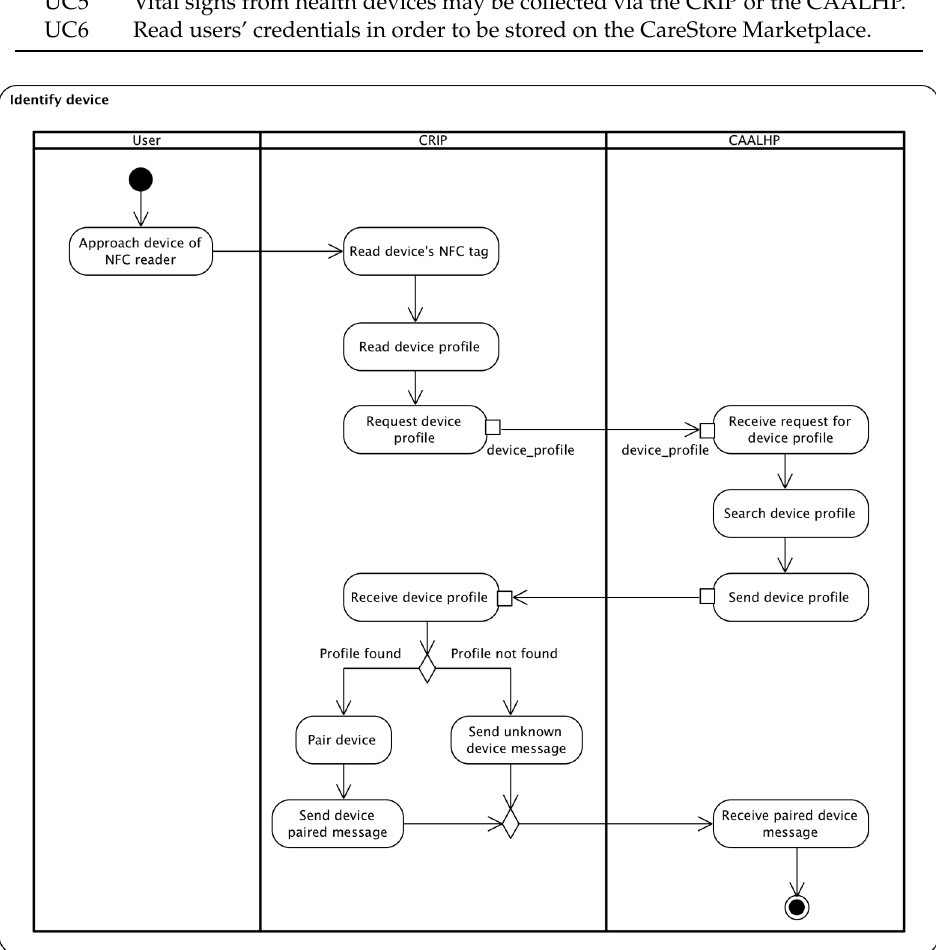
Figure 2. Interaction between the CRIP and CAALHP subsystems of CareStore for identification of a personal health device. The interaction between the Marketplace and CAALHP It is not explicitly depicted, but it is performed when the CAALHP searches for a device profile.